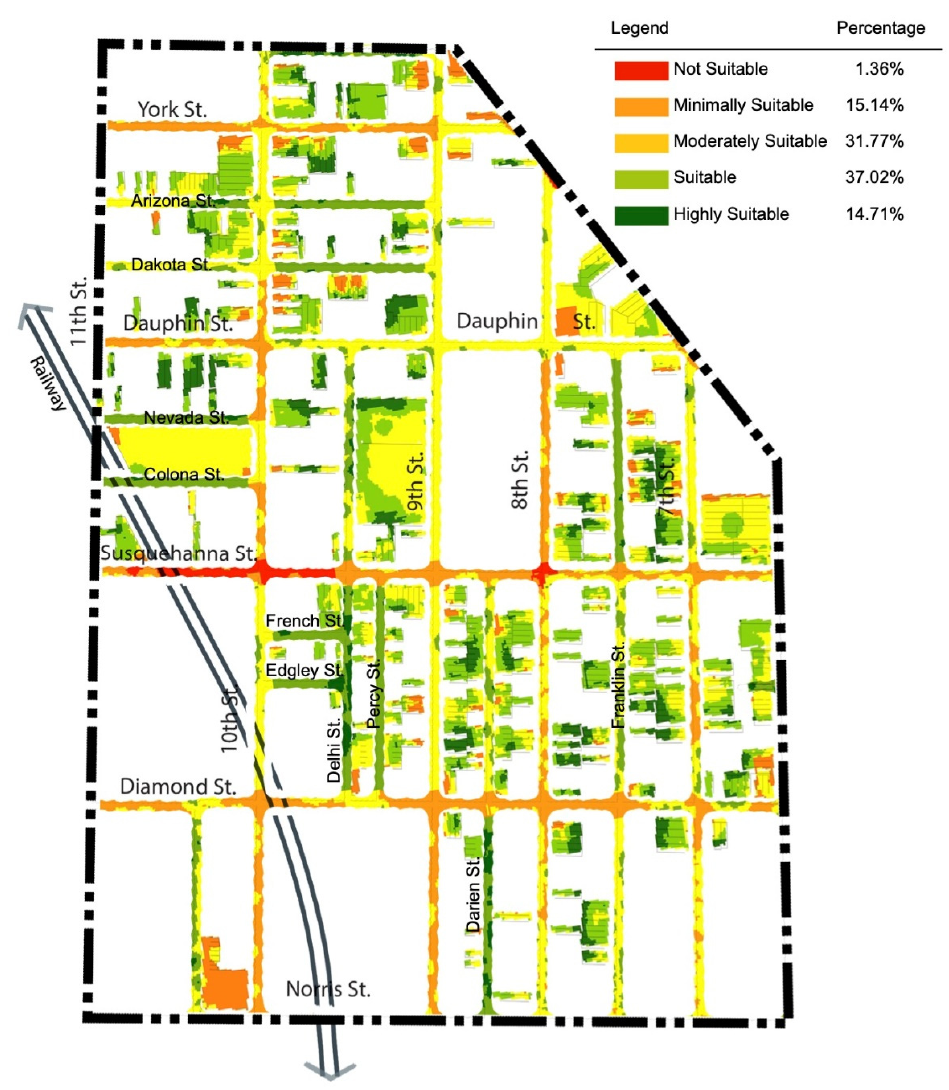
Figure 5. Final GIS Suitability